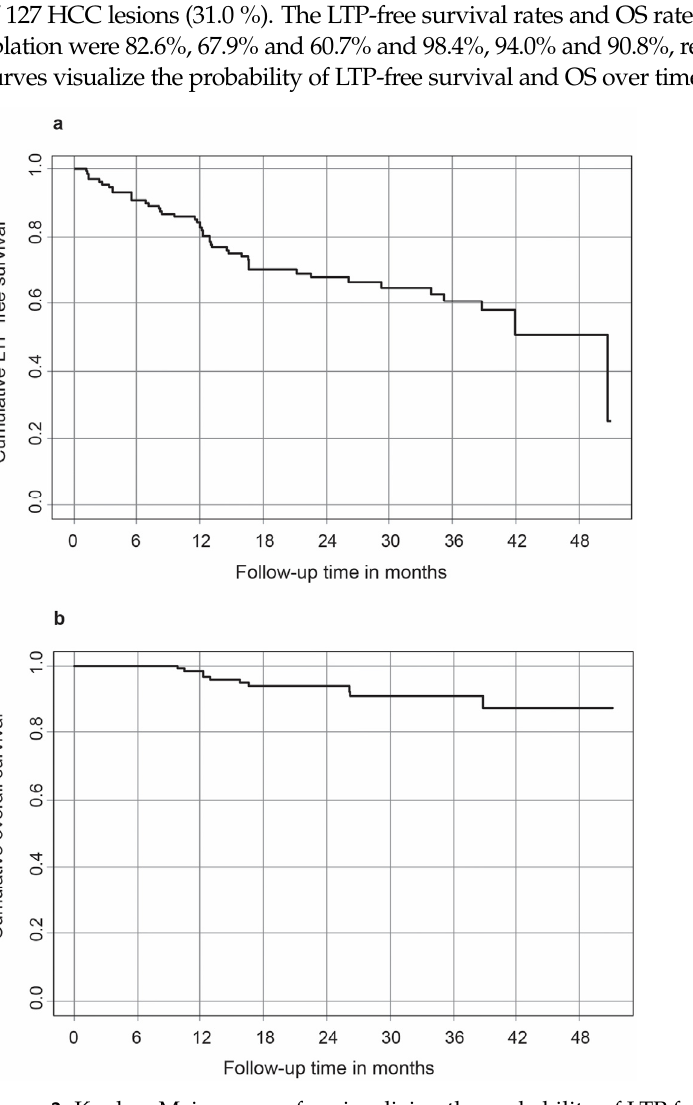
Figure 3. Kaplan–Meier curves for visualizing the probability of LTP free survival ( a ) and OS over time ( b ).